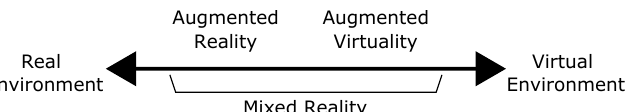
Figure 1. The reality–virtuality continuum, reproduced with permission from